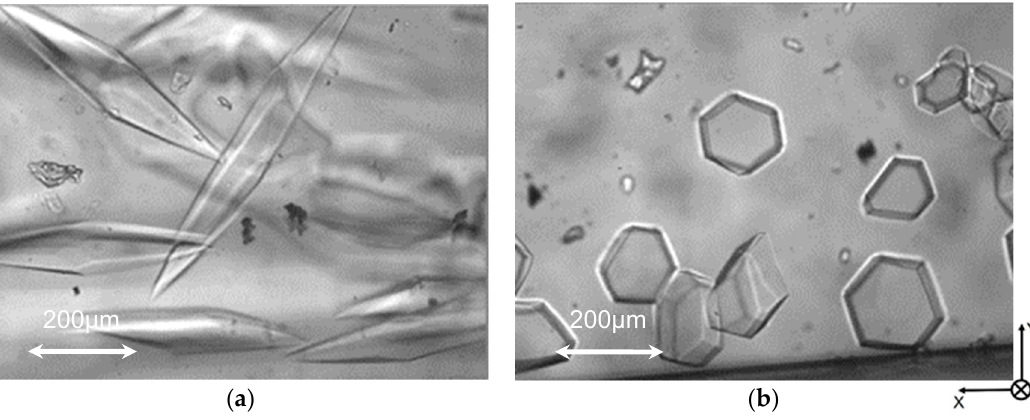
Figure 6. Typical ice particles observed in the flow of ice slurry in the case where the preheated HPLC6 solution was used. ( a ) In the case of unheated HPLC6 solution; ( b ) In the case of preheated HPLC6 solution. Black dots are the shadows of dust deposited on the outer surfaces of the channel.